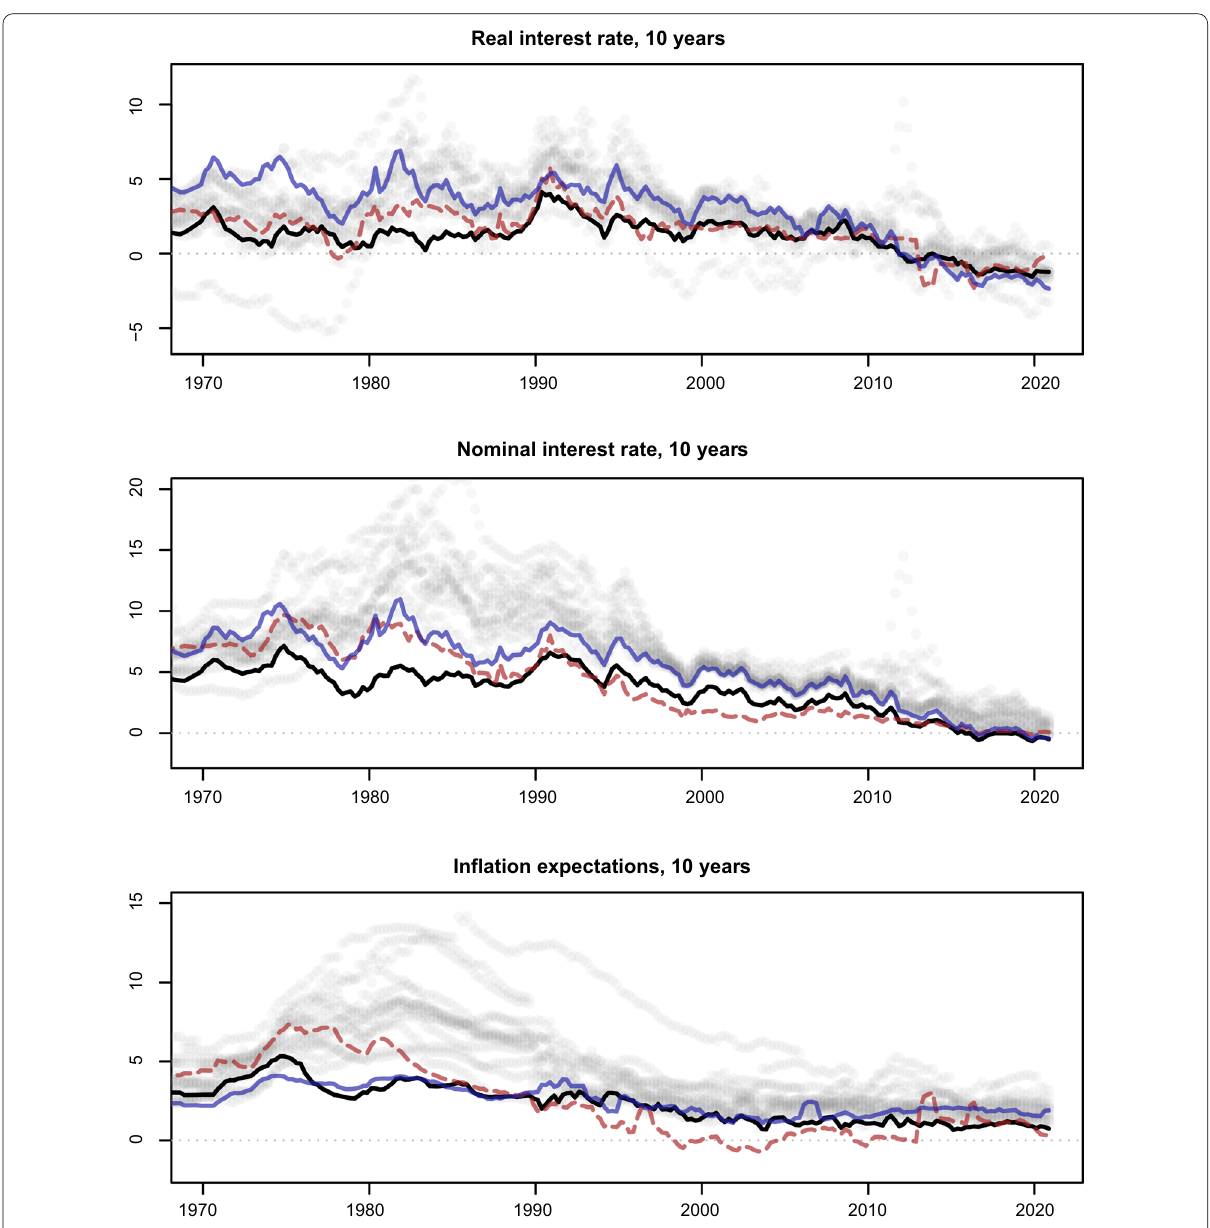
Fig. 3 Interest rate decompositions. This figure shows the decomposition of 10‑year nominal rates (first plot) into a real rate component (second plot) and inflation expectations (third plots). Interest and inflation rates are expressed in percentage points. The computation of inflation expectations is detailed in Sect. A.2. The blue line and the dashed red line, respectively, correspond to Germany and Japan. The grey dots correspond to the other 14 countries of the Jordà et al. (2015) database